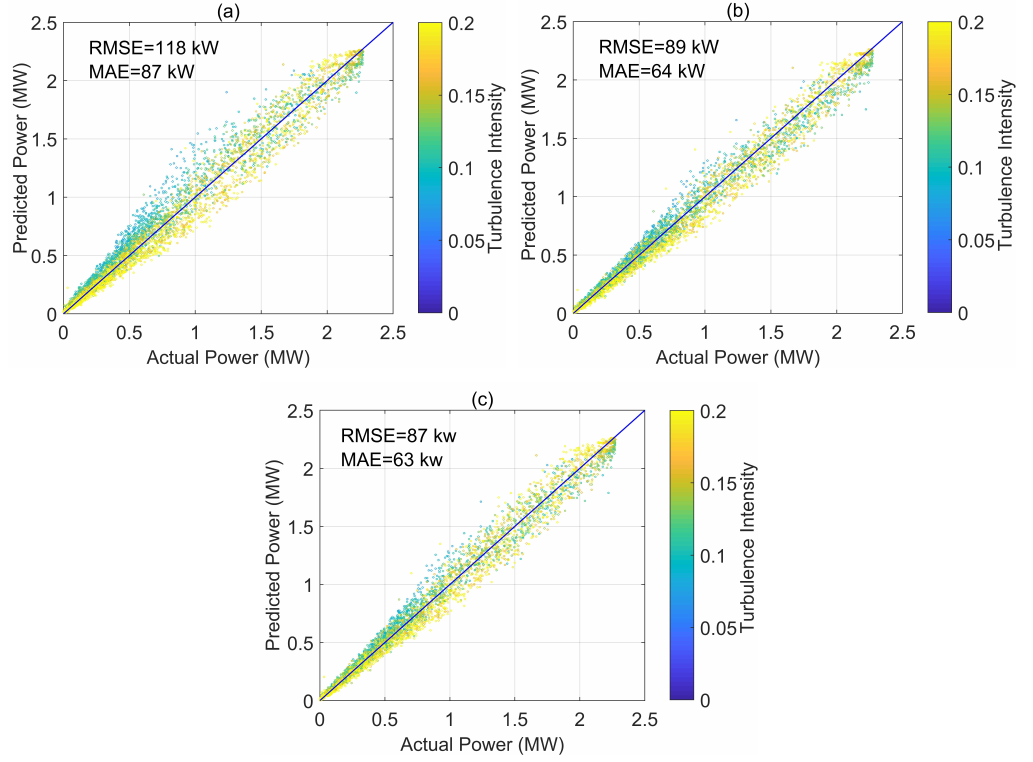
Figure 9. Performance of: ( a ) standard power curve; ( b ) ten-minute version of the model; and ( c ) one-second version of the model, when a reference density of ρ 0 = 1.225 kg · m − 3 is